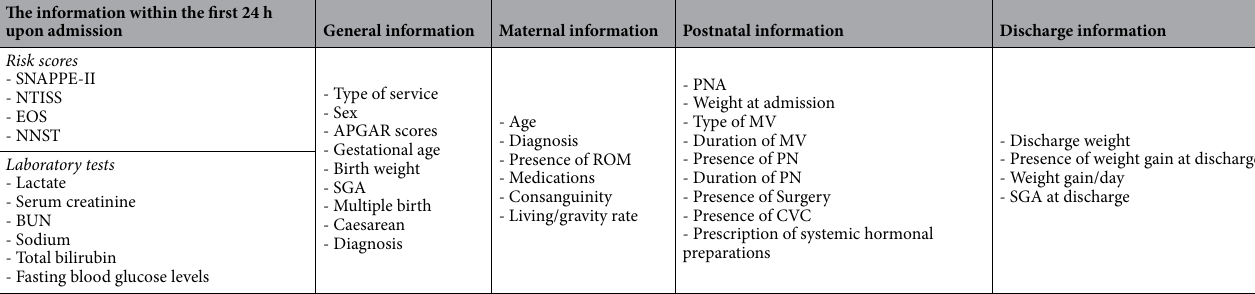
Table 1. Data acquisition parameters of the study. SNAPPE-II Score for neonatal acute physiology with perinatal extension-II, NTISS Neonatal therapeutic intervention scoring system, EOS Early-onset sepsis